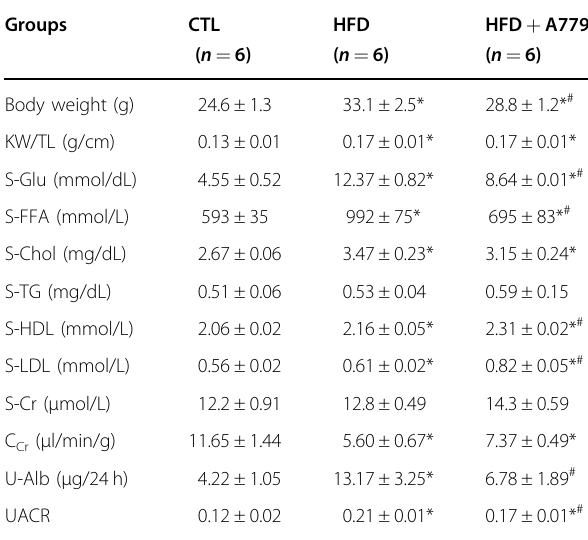
Table 2 Functional data of HFD mice with or without A779